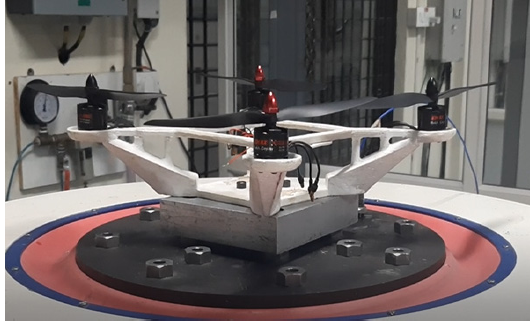
Figure 15. Quadcopter structure fixed to the shaker.